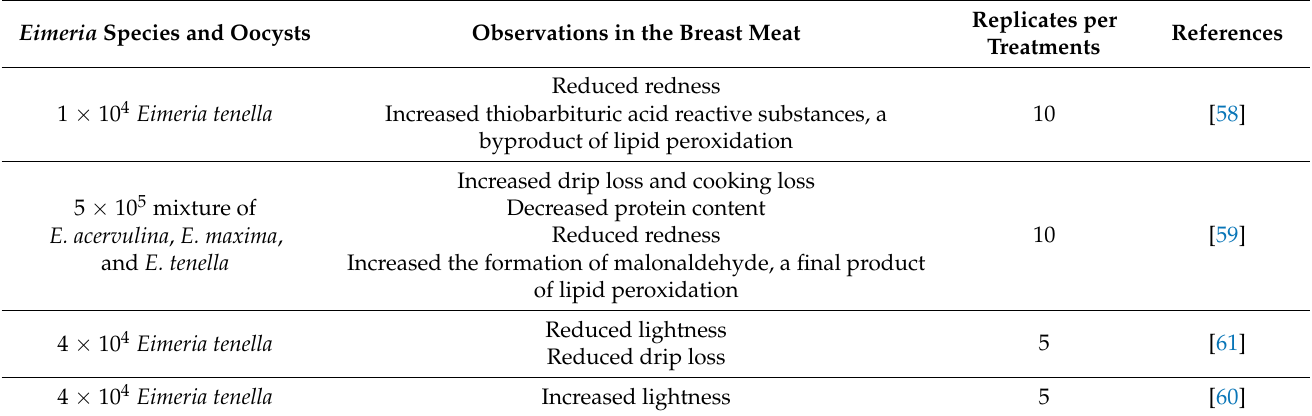
Table 2. Effects of Eimeria infection on breast meat quality in broiler